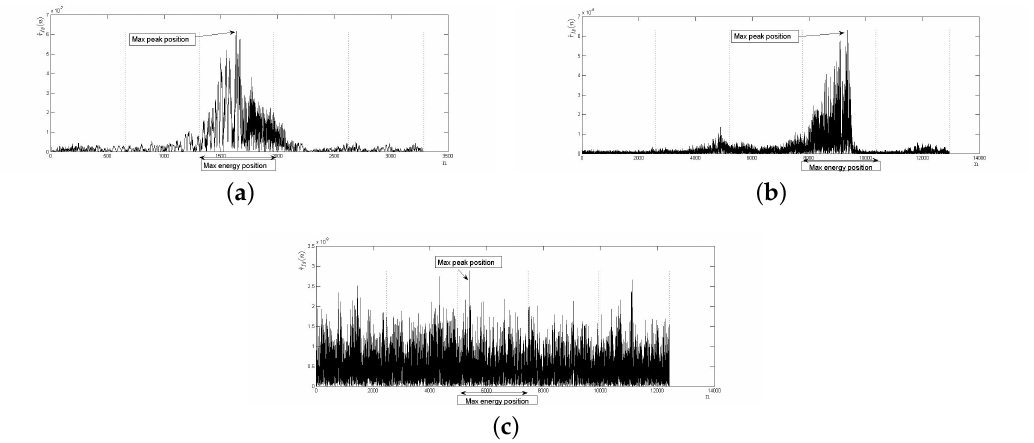
Figure 10. Examples of the BLPOC function verification process through equidistant vertical regions: ( a ) genuine matching correctly verified as accepted; ( b ) impostor matching correctly verified as rejected; and ( c ) impostor matching incorrectly verified as